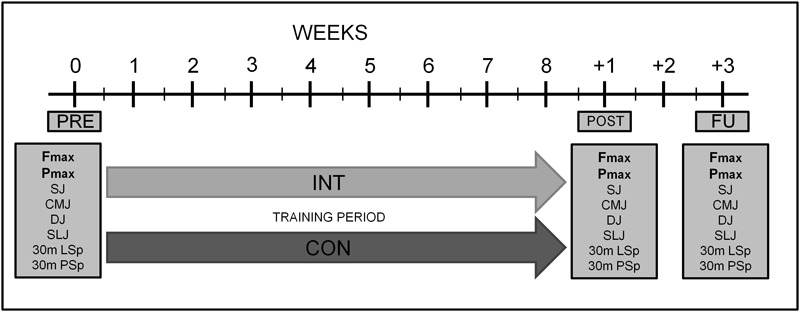
Schematic representation of the experimental protocol. Fmax, maximal isometric force; Pmax, maximal isoinertial power; SJ, Squat Jump; CMJ, Counter Movement Jump; DJ, Drop Jump; SLJ, Standing Long Jump; 30 m LSp, 30 m Linear Sprint; 30 m PSp, 30 m Pendulum Sprint; INT, WB-EMS Intervention Group; CON, Traditional strength training Group.